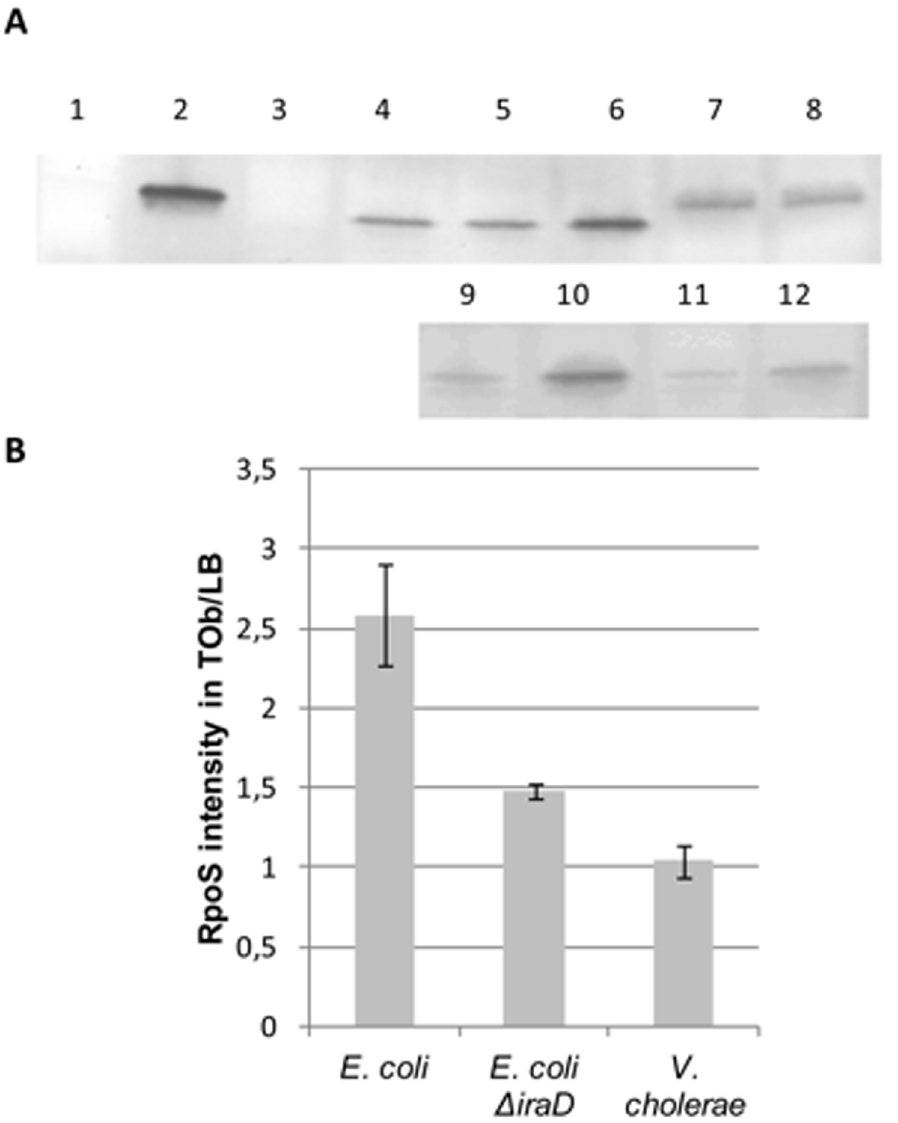
Figure 6. RpoS protein levels are higher in the presence of sub-MIC tobramycin in E.coli but unchanged in V.cholerae . Overnight cultures were diluted to OD 0.1. Tobramycin treatment at 0.5 m g/ml was initiated at OD 0.5 for one hour. The growth was then stopped and the western blotting was performed. Note that V. cholerae RpoS (335 aminoacids) is larger than E. coli RpoS (330 aminoacids). A: representative western blots using RpoS antibody. Wells: 1- V. cholerae D rpoS , 2- Purified E. coli RpoS (with His-tag, thus larger than native protein), 3- E. coli D rpoS , 4- and 9- E. coli grown in LB, 5- E. coli grown in Tob 0.05 m g/ml, 6- and 10- E. coli grown in Tob 0.5 m g/ml, 7- V. cholerae grown in LB, 8- V. cholerae grown in Tob 0.5 m g/ml, 11- E. coli D iraD grown in LB, 12- E. coli D iraD grown in Tob 0.5 m g/ml B: Bands corresponding to RpoS were quantified. The histogram represents the intensity of fluorescence of secondary antibody (Alexa) obtained in tobramycin over the intensity obtained in LB in at least two independent experiments.